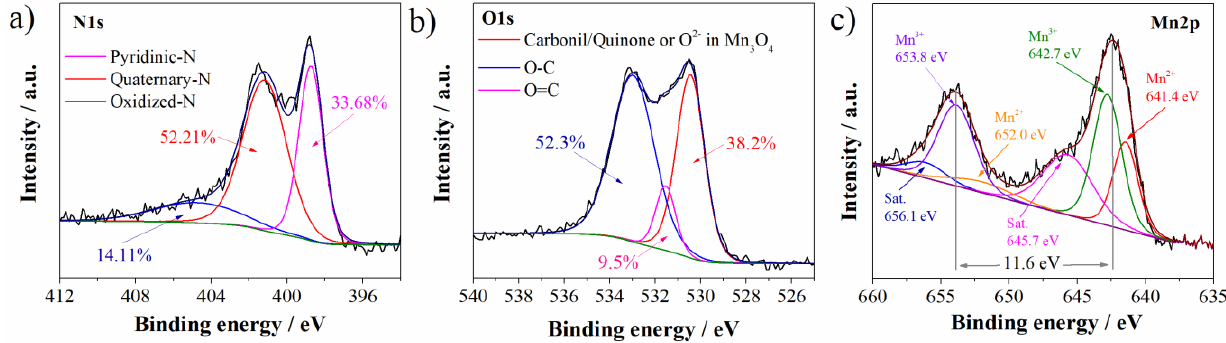
Figure 2. Deconvoluted ( a ) N1s, ( b ) O1s, and ( c ) Mn2p XPS spectra of Mn 3 O 4 @N-doped carbon.